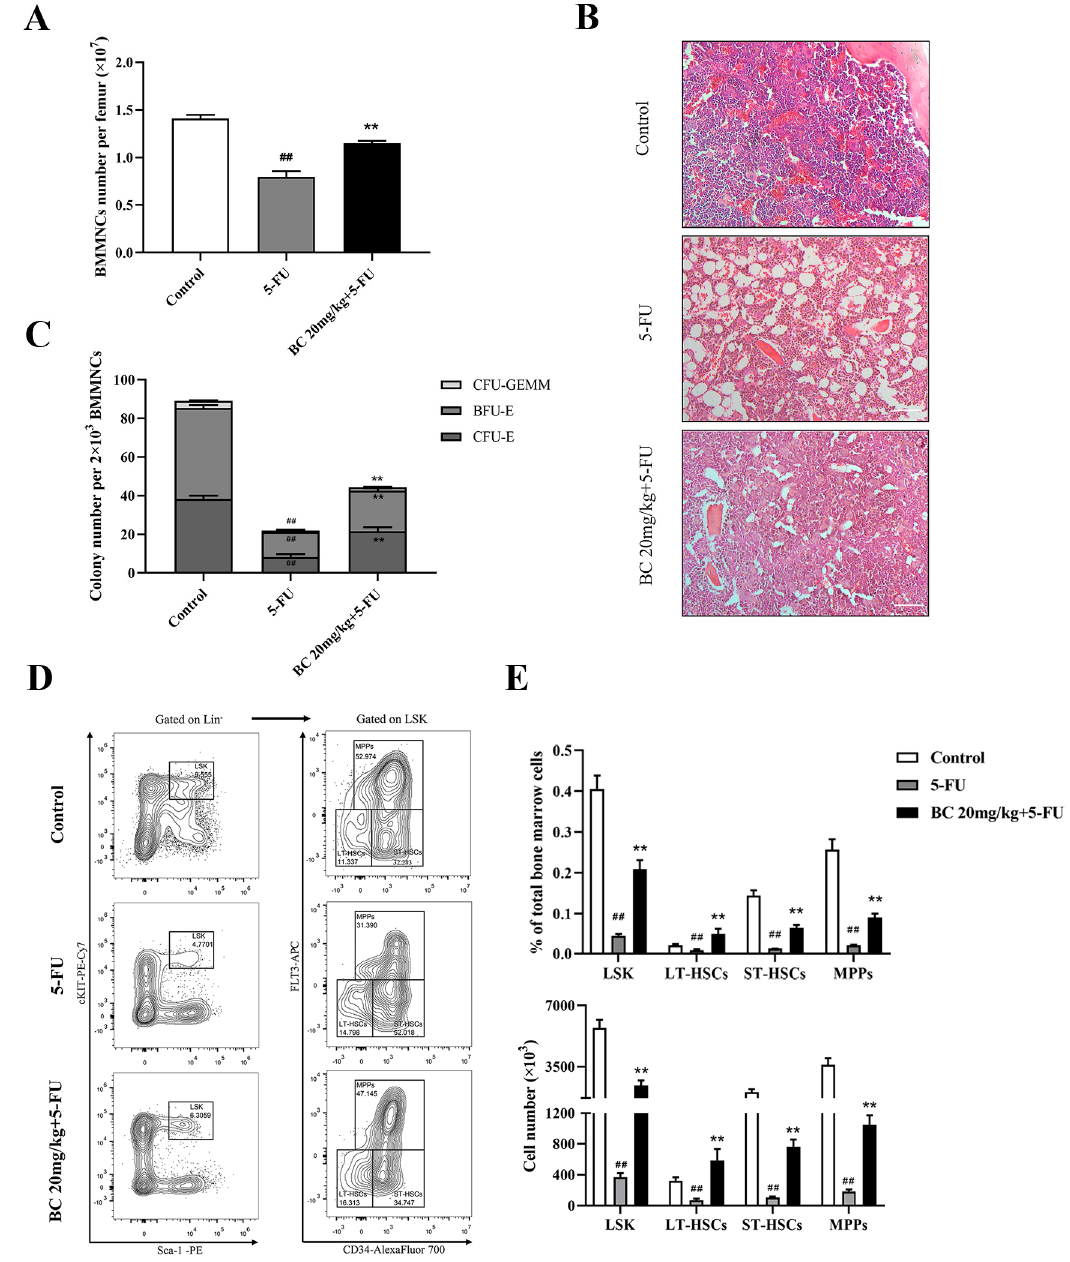
Figure 7. BC pretreatment protects bone marrow hematopoietic stem and progenitor cells from 5 − FU injury in mice. ( A ) Counting of the total cells in BM isolated from unilateral femur of mice treated as shown in Figure 6C ( n = 5). ( B ) Histopathological analysis of bone marrow from unilateral femur of mice treated as shown in Figure 6C by HE staining. Scale bar: 100 μ m. ( C ) CFU assay of BM cells isolated from unilateral femur of mice treated as shown in Figure 6C ( n = 3). ( D ) Representative flow cytometry profiles showing the proportions of LSK (left), LT − HSCs, ST − HSCs and MPPs (right) in BM of mice treated as shown in Figure 6C ( n = 5). Gates shown identify the LSK populations from Lineage - (Lineage negative cells) population and the LT − HSCs, ST − HSCs and MPPs subpopulations from LSK population. ( E , F ) The proportions and absolute numbers of LSK cells, LT − HSCs, ST − HSCs and MPPs in BMMNCs based on flow cytometry analysis shown in ( D ) ( n = 5). All data are shown as mean ± SEM. ## p < 0.01, compared with control group. ** p < 0.01, compared with 5-FU group (Student’s t test).